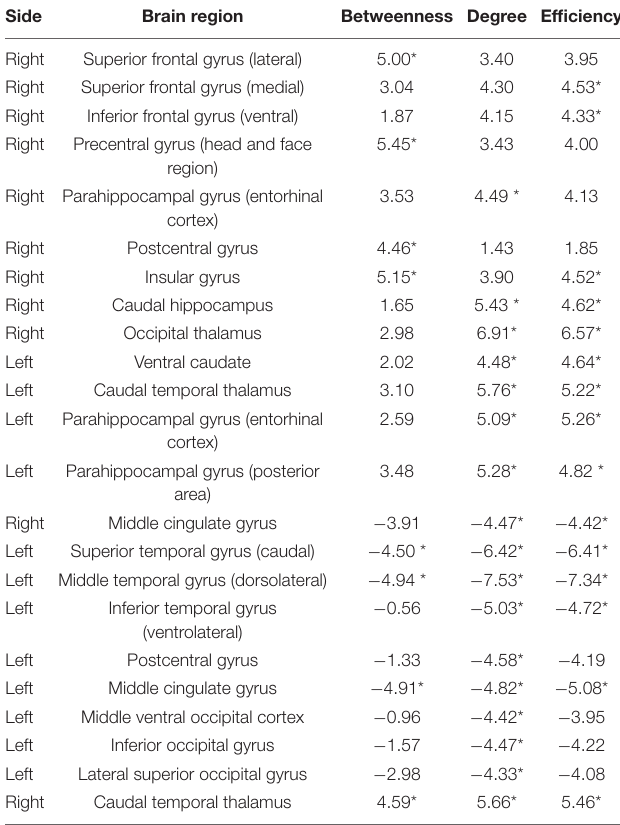
TABLE 2 | Regions with altered nodal centralities in subjects with experimental orthodontic pain compared with control subjects. Side Brain region Betweenness Degree